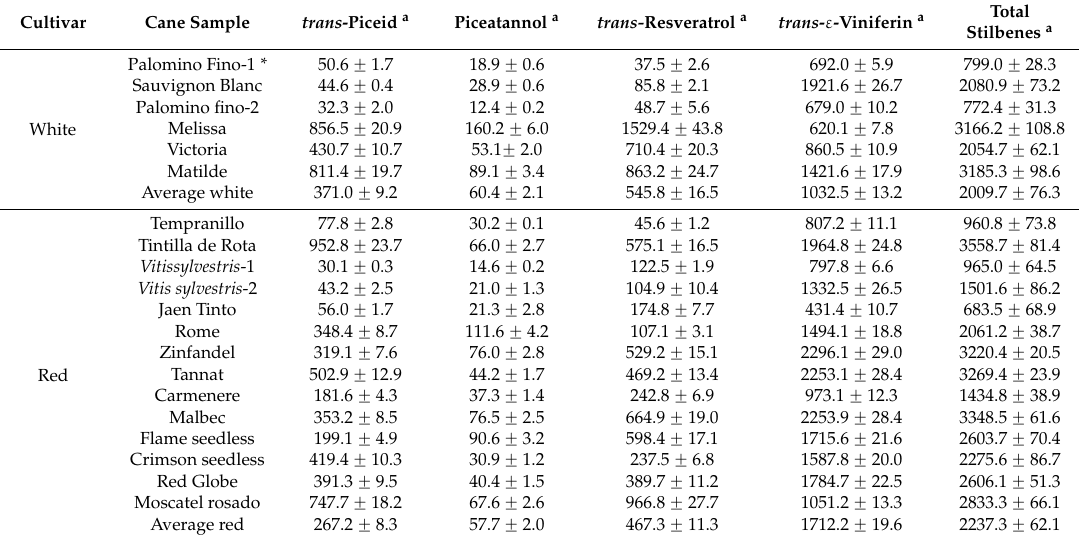
Table 4. Stilbene concentrations in twenty grape cane samples ( n = 3) from the 2013 pruning season.